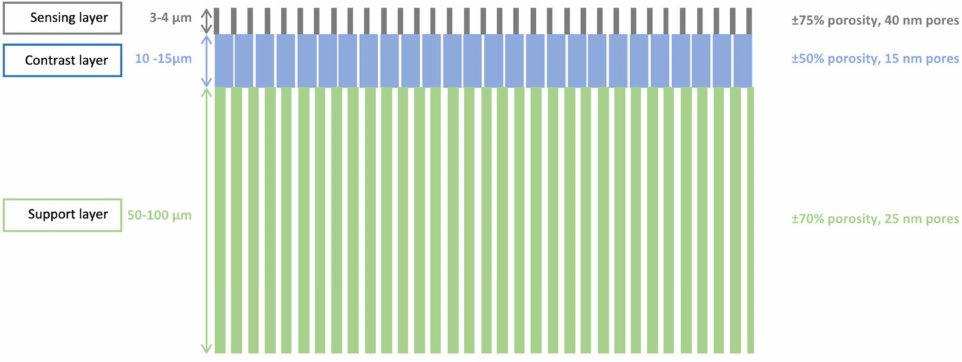
Figure 2. Schematic of a tri-layered PSi membrane, successively etched at 225, 50 and 100 mA/cm 2 . The fabricated membranes have two shapes: either 4 mm 2 squares, or 3.14 mm 2